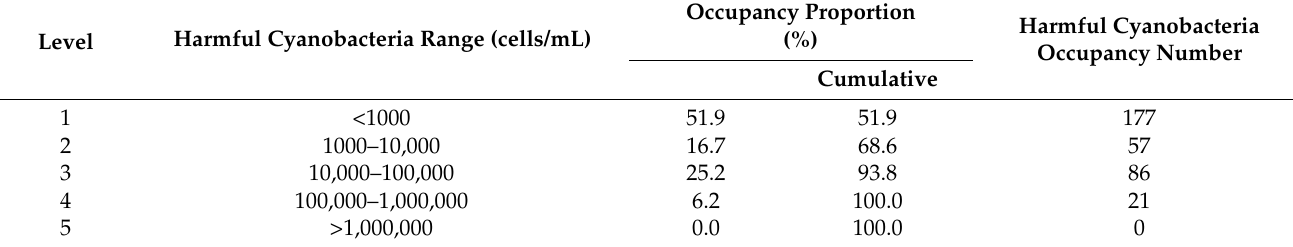
Table 6. Harmful cyanobacteria measured at the Changnyeong-Haman